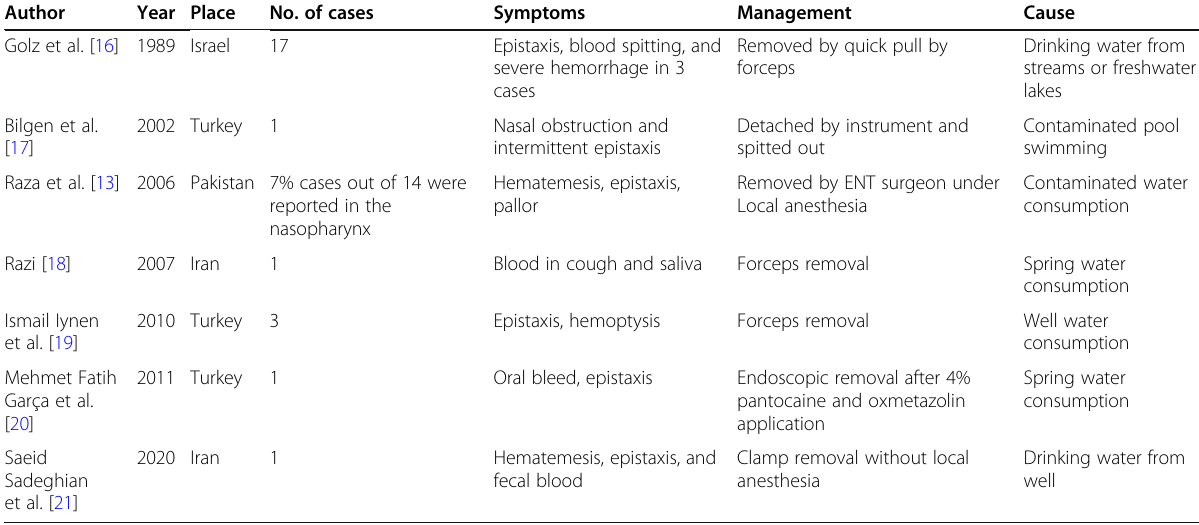
Table 1 Previously reported cases of nasopharyngeal leech